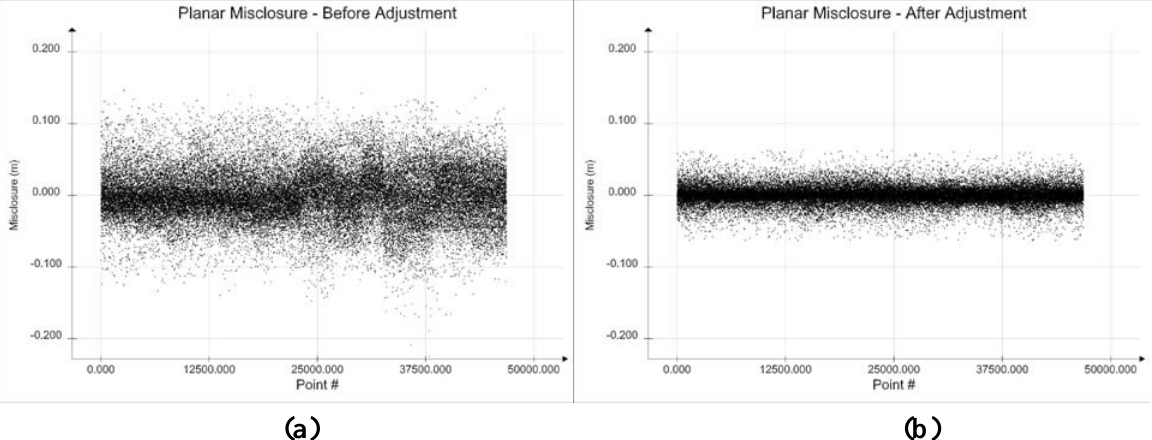
Figure 4. (a) Planar Misclosure Before Adjustment. (b) Planar Misclosure After